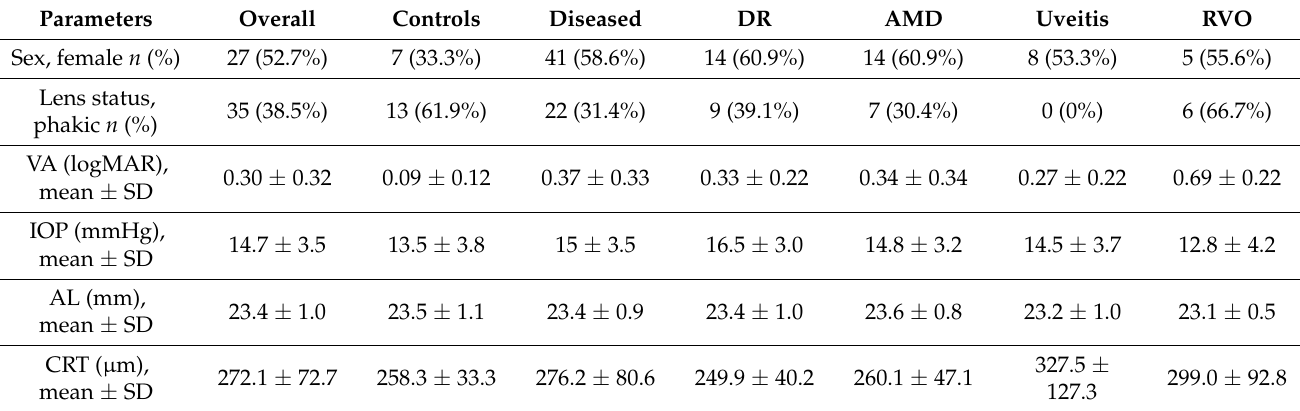
Figure 3. Vessel density values calculated with the tested algorithms for control and diseased eyes in choriocapillaris angiograms. Subgroups of diabetic retinopathy (DR), age-related macular